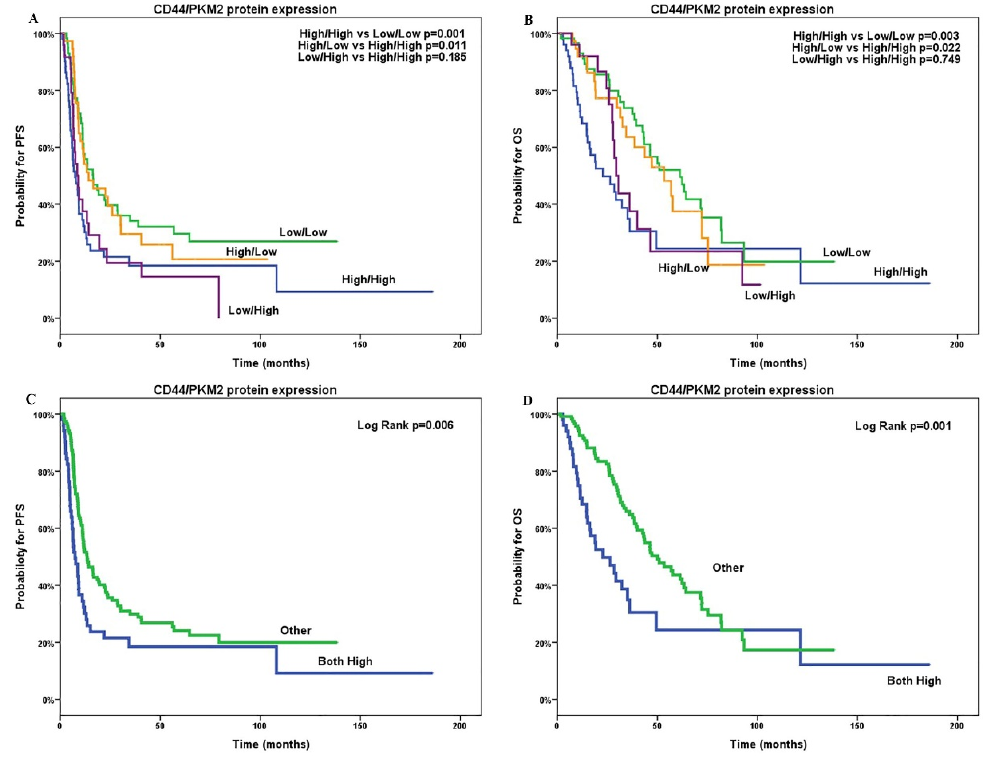
Figure 5. Combinations of CD44 and PKM2 protein co-expression and progression-free survival (PFS; A , C ) and overall survival (OS; B , D ) in patients with epithelial ovarian cancer. PFS: progression-free survival; OS: overall survival. Table 2. Tumoral expression of PKM2 and CD44 and patients' outcome.